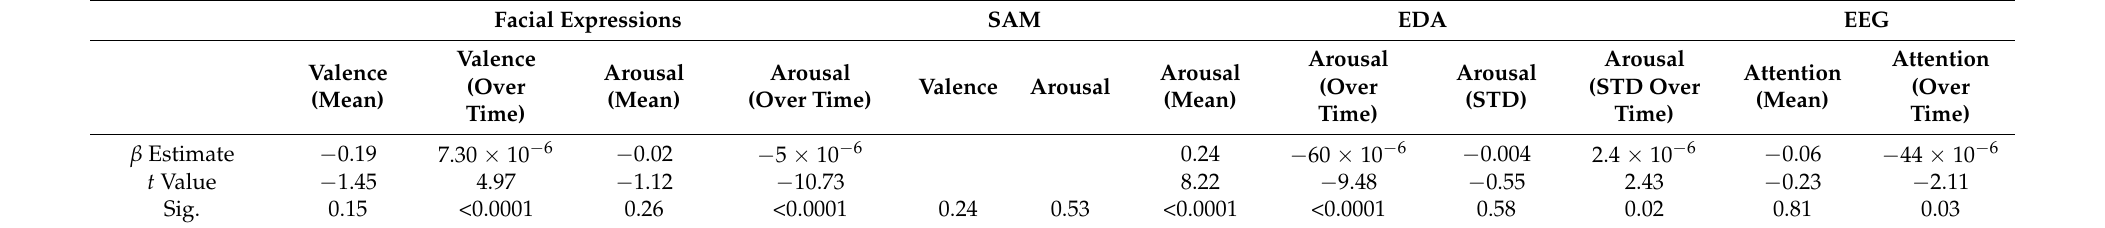
Table 3. Engagement results for lecture condition compared to infographic